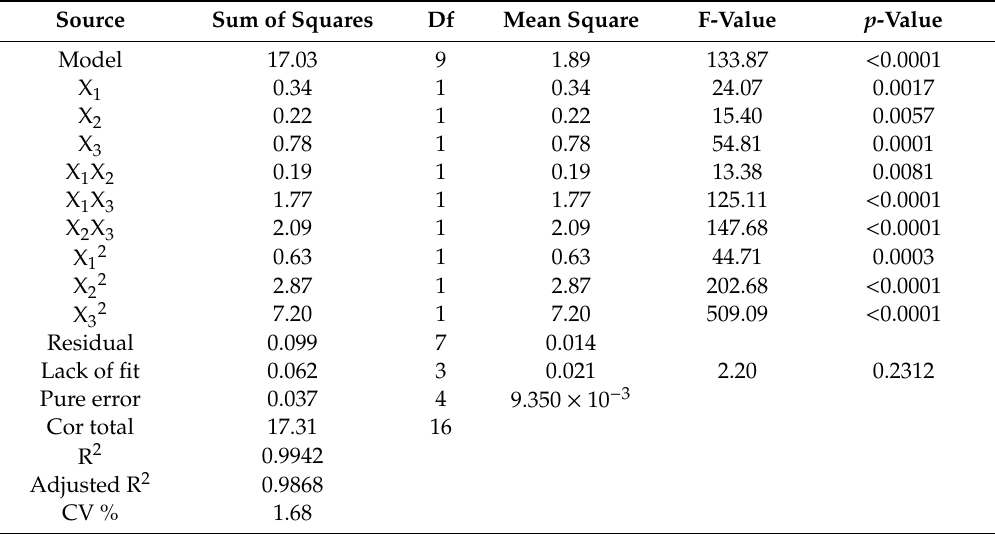
Table 2. Analysis of variance (ANOVA) testing the fitness of the regression